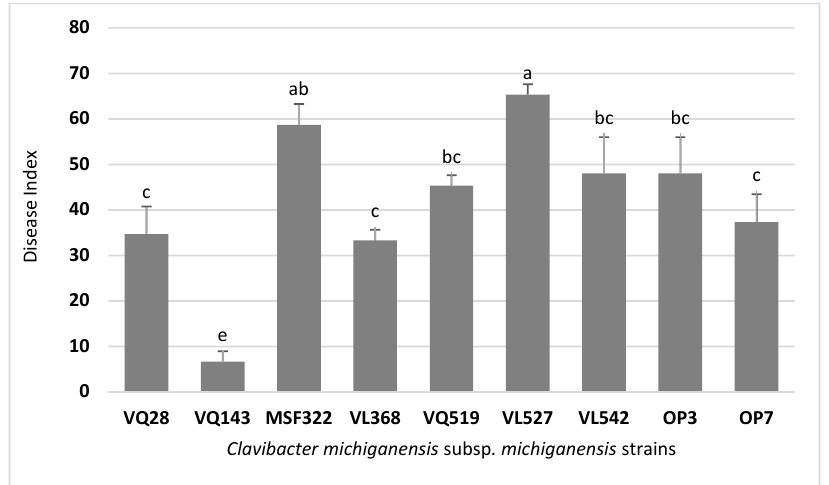
Figure 2. Results of virulence assay on tomato cv. San Pedro inoculated with nine Chilean C. michiganensis subsp. michiganensis strains. Data are expressed as mean ± standard deviation ( n = 15). Means with different letters indicate significant differences from each other ( p ≤ 0.05). Values obtained from the uninoculated control (zero) were excluded from the analyses of variance.